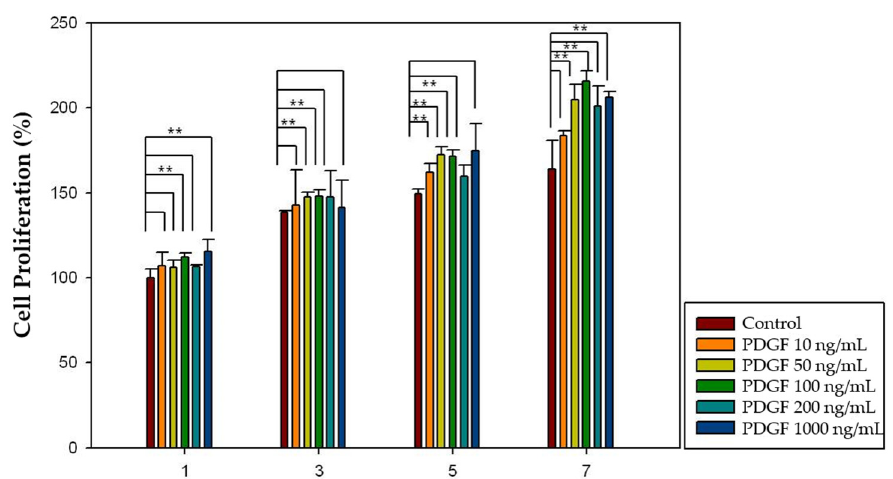
Figure 11. The effect of PDGF-BB on pulp cell proliferation. The 50, 100, and 500 ng/mL concentrations showed significantly increased pulp cell proliferation rates in the 3-, 5-, and 7-day groups ( p < 0.05). The 100 ng/mL concentration showed significantly increased pulp cell proliferation rates in all four groups ( p < 0.05). The results are expressed as mean values ± standard deviation. ** indicates the statistically significant differences ( p < 0.05). PDGF, platelet-derived growth factor.